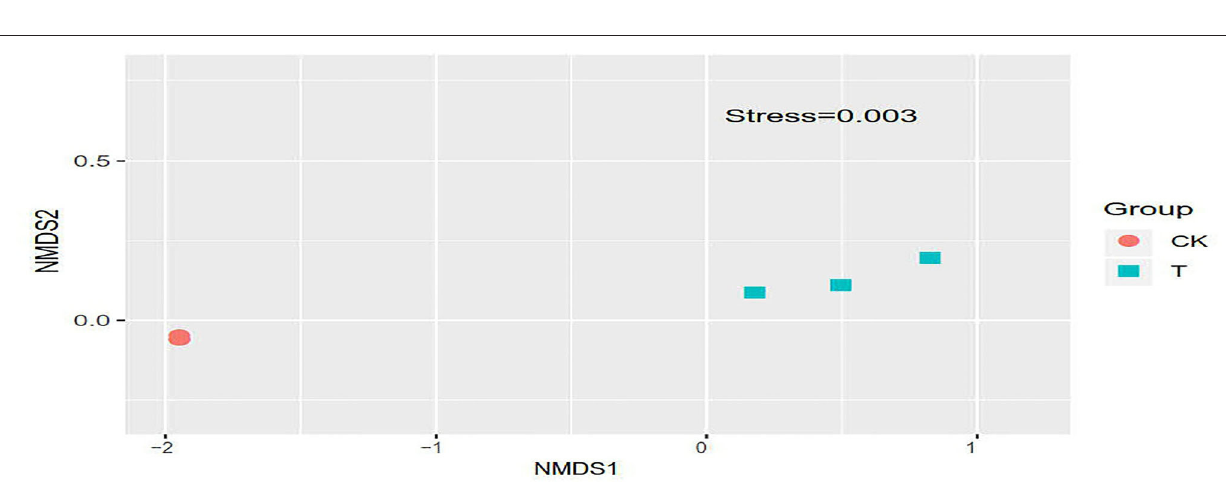
FIGURE 7 | Non-Metric Multi-Dimensional Scaling plot based on weighted UniFrac distance. In each sample name, CK and T represent the sample from SBM and FSBM, respectively. Points with the same pattern represent the three replicate samples from the same